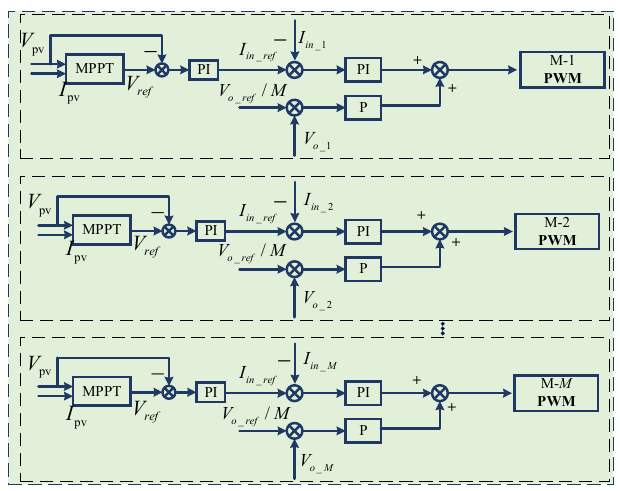
Figure 5. Distributed control strategy diagram of an IPOS combined converter.